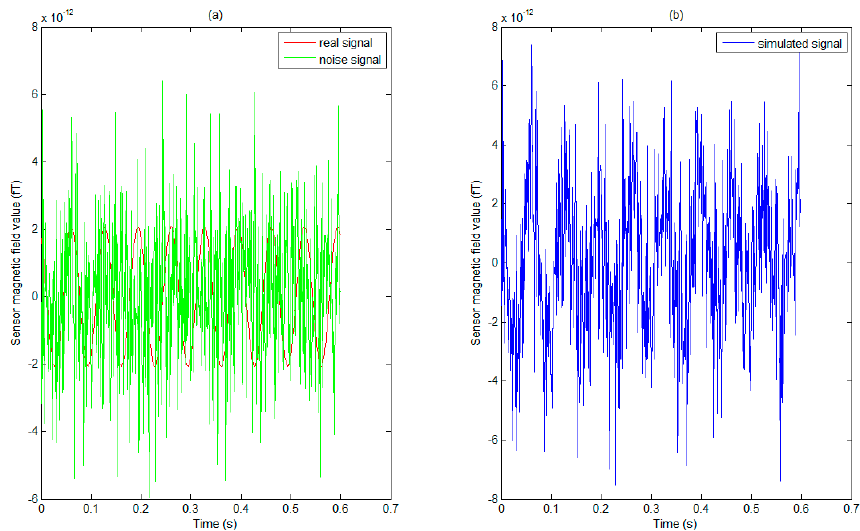
Figure 3. The real signal, the noise signal and the simulation signal were described through one of the sensors signal. ( a ) The red waveform represents the real signal, and the green signal represents noise under a 600 ms time window; ( b ) The simulation signal was composed of a real signal and an additive noise signal, in which the real signal is a cosine oscillation, and the noise signal is Gaussian white noise (SNR = 0.459).